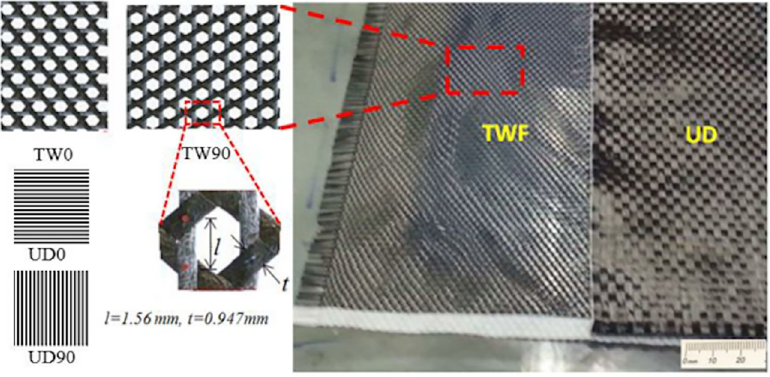
Fig 1. Dry TW fabric with its highlighted unit cell and dry UD carbon fiber